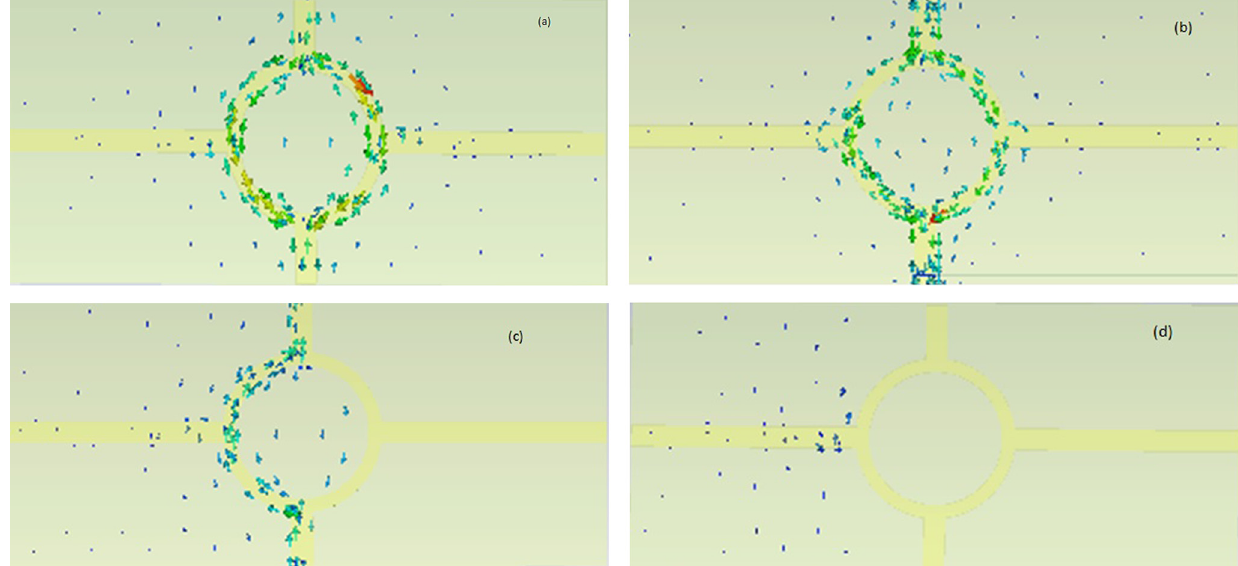
Fig. 6. The simulated surface current distributions of the unit-cell structure of the proposed metamaterial at different resonance frequencies: (a) FR4 at 7 GHz, (b) Sample A at 9.6 GHz, (c) Sample B at 8.31GHz, (d) Sample C at